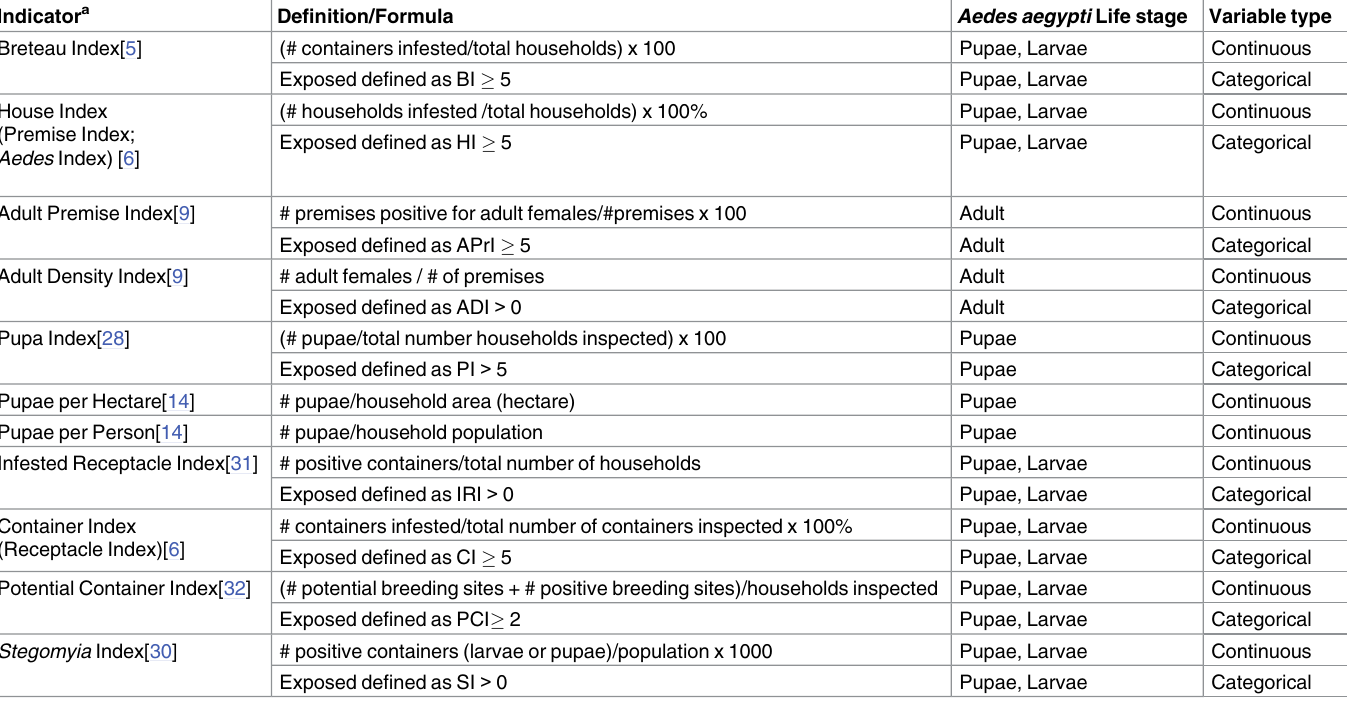
Table 2. Summaryof block-level indicators of Aedes aegypti tested for an association with seroconversion to DENV Indicator